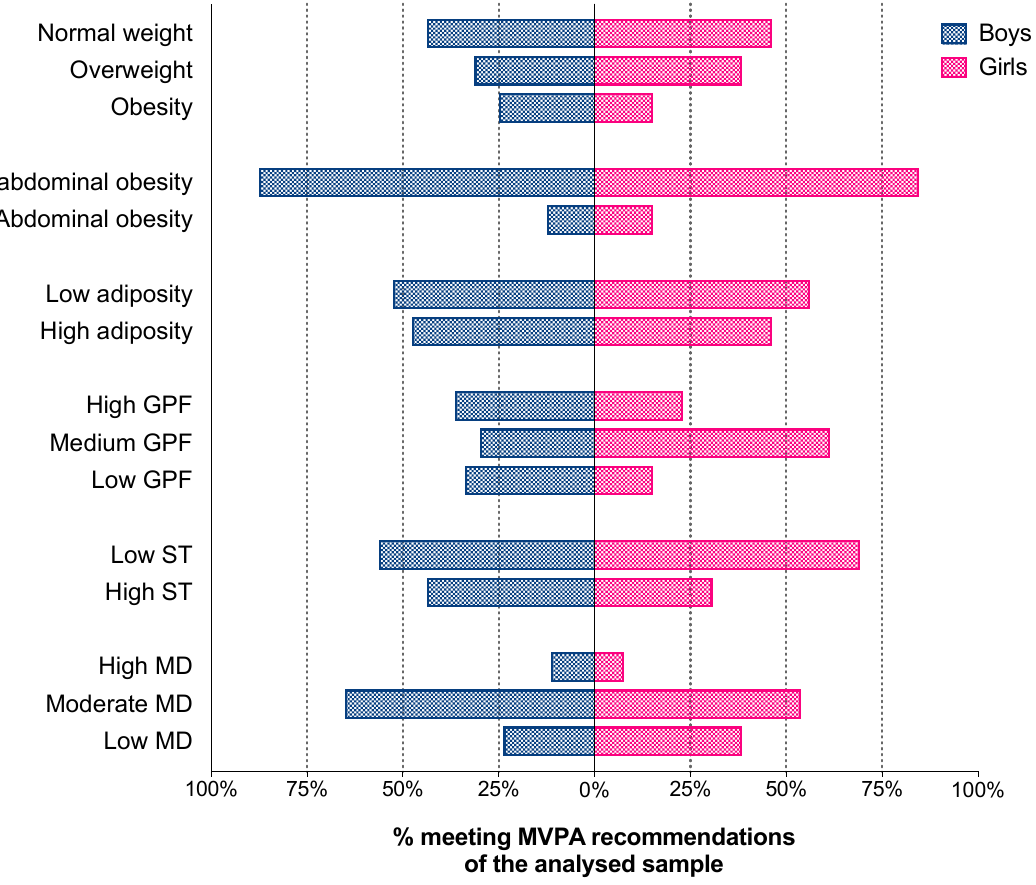
Figure 1. Proportion of participants meeting the moderate-to-vigorous physical activity and according the different dependent variables of study. Data expressed as relative frequencies. GPF: Global physical fitness; MVPA: Moderate-to-vigorous physical activity; MD: Mediterranean Diet; ST: Screen time; WHtR: Waist-to-height ratio. Adjusted by age, type of schooling and area of residence.